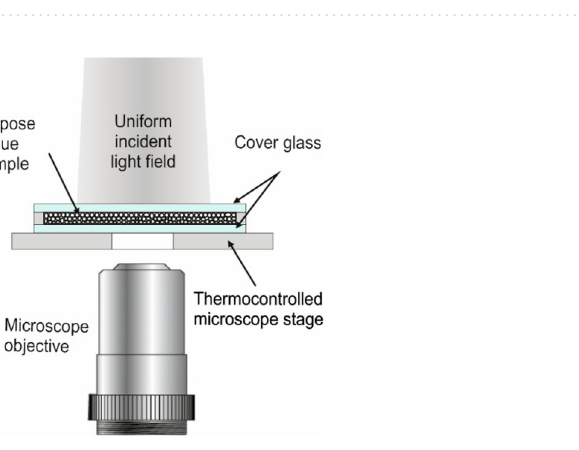
Figure 2. Bright-field light microscopy images of 500 µm thick porcine adipose tissue obtained at: ( A ) 24 °C, ( B ) 25 °C, ( C ) 27 °C, ( D ) 30 °C, ( E ) 37 °C. Arrows show the brightest focusing points. Scale bare corresponds to 50 µm.